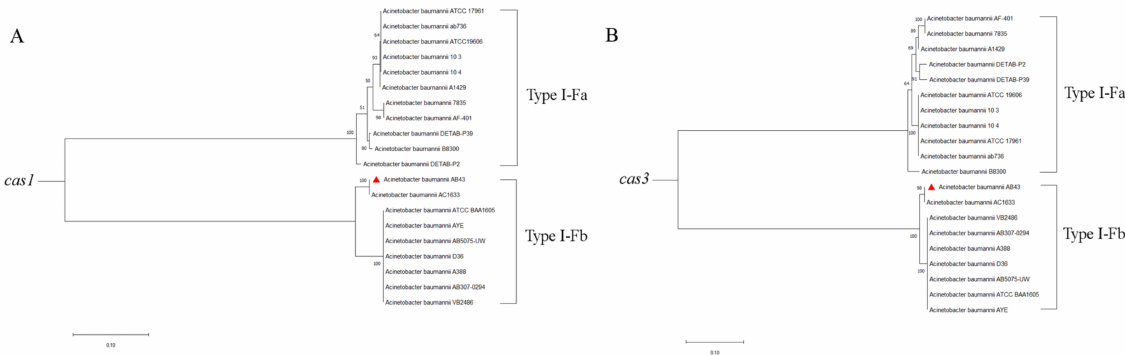
Figure 5. Phylogenetic tree of cas1 ( A ) and cas3 ( B ) genes, using the ClustalW algorithm to calculate and the maximum likelihood method to construct the phylogenetic tree in MEGA 7.0. The numbers at the top of the lines indicate the bootstrap value (1000